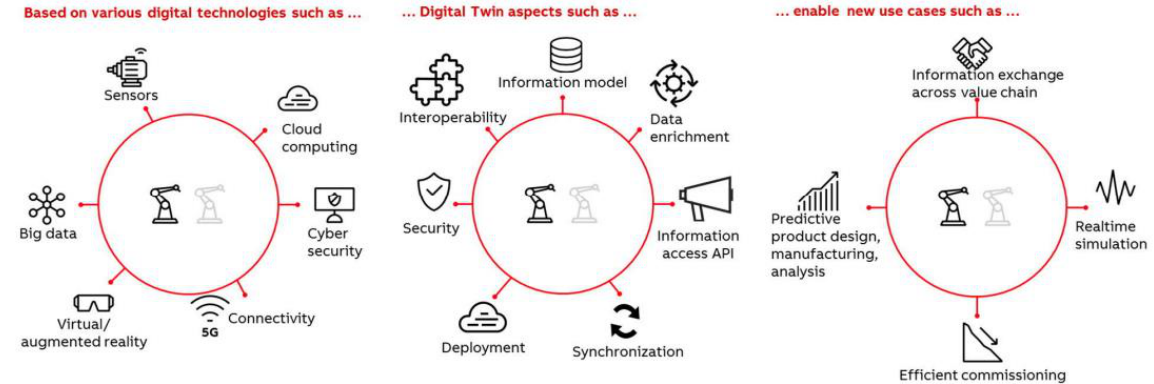
Figure 15. Overview of some concepts associated with a DT [107].